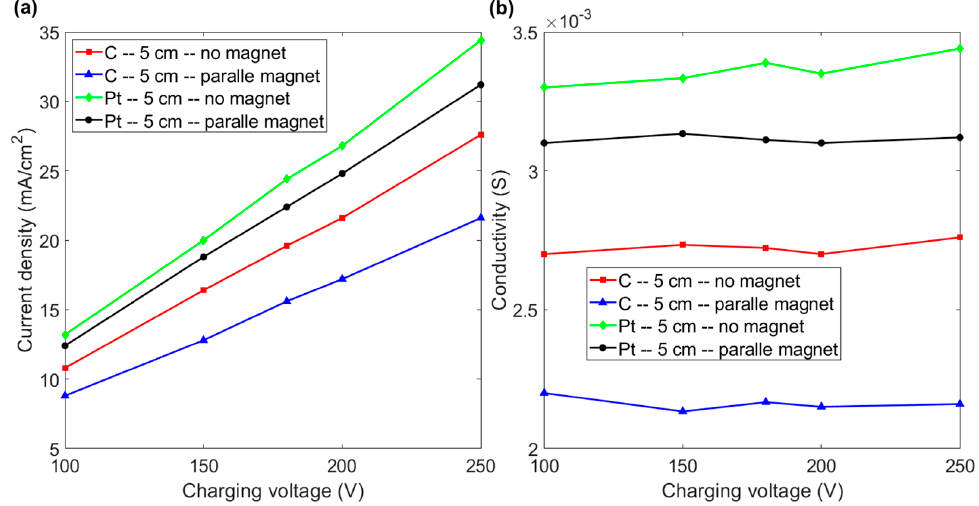
Figure 5. ( a ) Current density vs. charging voltage for graphite and platinum electrode with and without a magnet for an inter-electrode distance of 5 cm. ( b ) Conductivity vs. charging voltage for the various experimental layouts in Figure 5a.